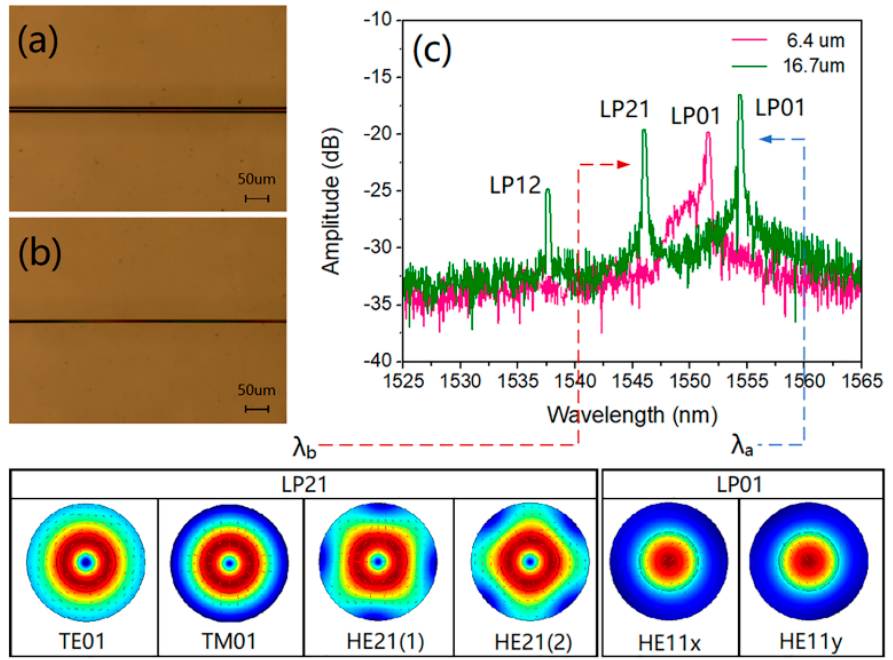
Figure 1. ( a , b ) Microscope images of the Co-MFBGS; ( c ) the reflection spectra of Co-MFBGS with diameters of 6.4 and 16.7 µ m, and the inset shows the spectral characteristics of the Co-MFBGS. The reflection spectra of the Co-MFBGS with diameters of 16.7 and 6.4 µ m were investigated, as shown in Figure 1c. It is clear that the Co-MFBGS with a diameter of 16.7 µ m has a core mode and two cladding modes, but the Co-MFBGS with a 6.4 µ m diameter has only a core mode, the wavelength range from 1525 to 1565 nm. Accordingly, the 16.7 µ m Co-MFBGS was selected as the test sensor for the rest of the experiments.